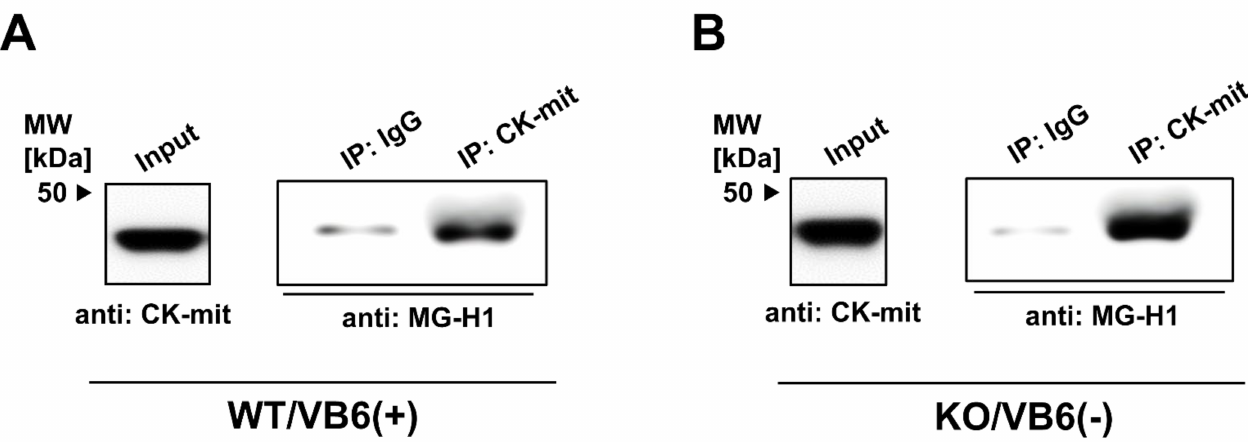
Figure 5. Quantitative detection of MG-H1-modified U-type Creatine kinase by immunoprecipitation. Proteins extracted from the HIP of WT/VB6(+) ( A ) or KO/VB6( − ) ( B ) mice were immunoprecipitated with mouse IgG or mouse antibody against CK-mit ( A , B ). HIP homogenate (Input) was loaded as a control. Each sample recovered was electrophoresed by SDS-PAGE (5–20% gradient gel) and immunoblotted with the antibody against MG-H1. A typical result from duplicate experiments is presented.